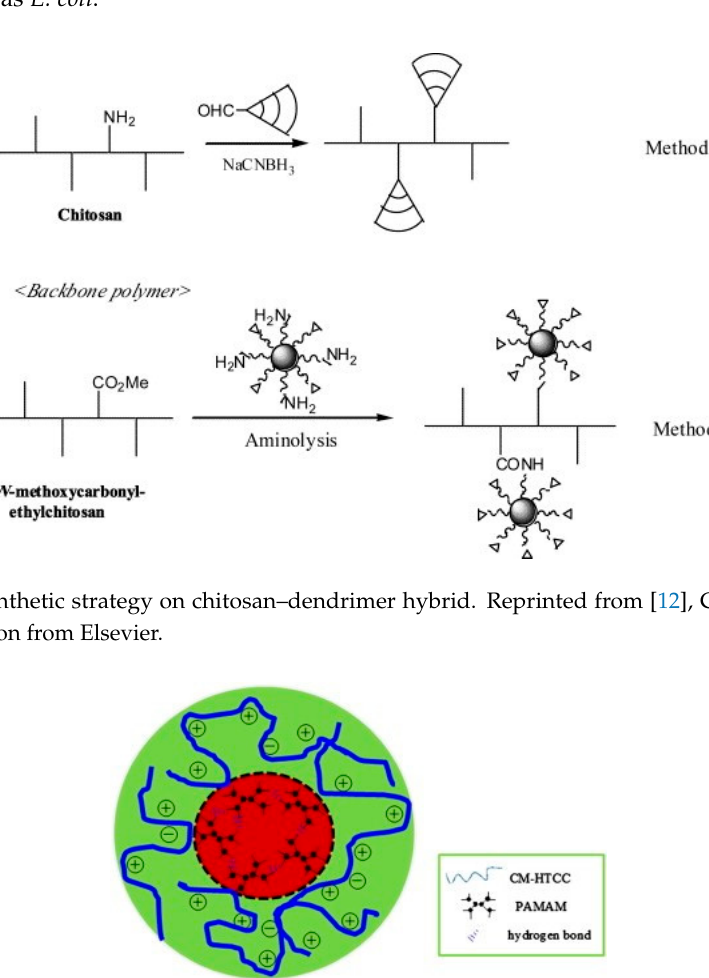
Figure 17. Putative schematic structure of CM-HTCC/PAMAM dendrimer core-shell nanoparticles. Reprinted from [210], Copyright 2012, with permission from Elsevier.